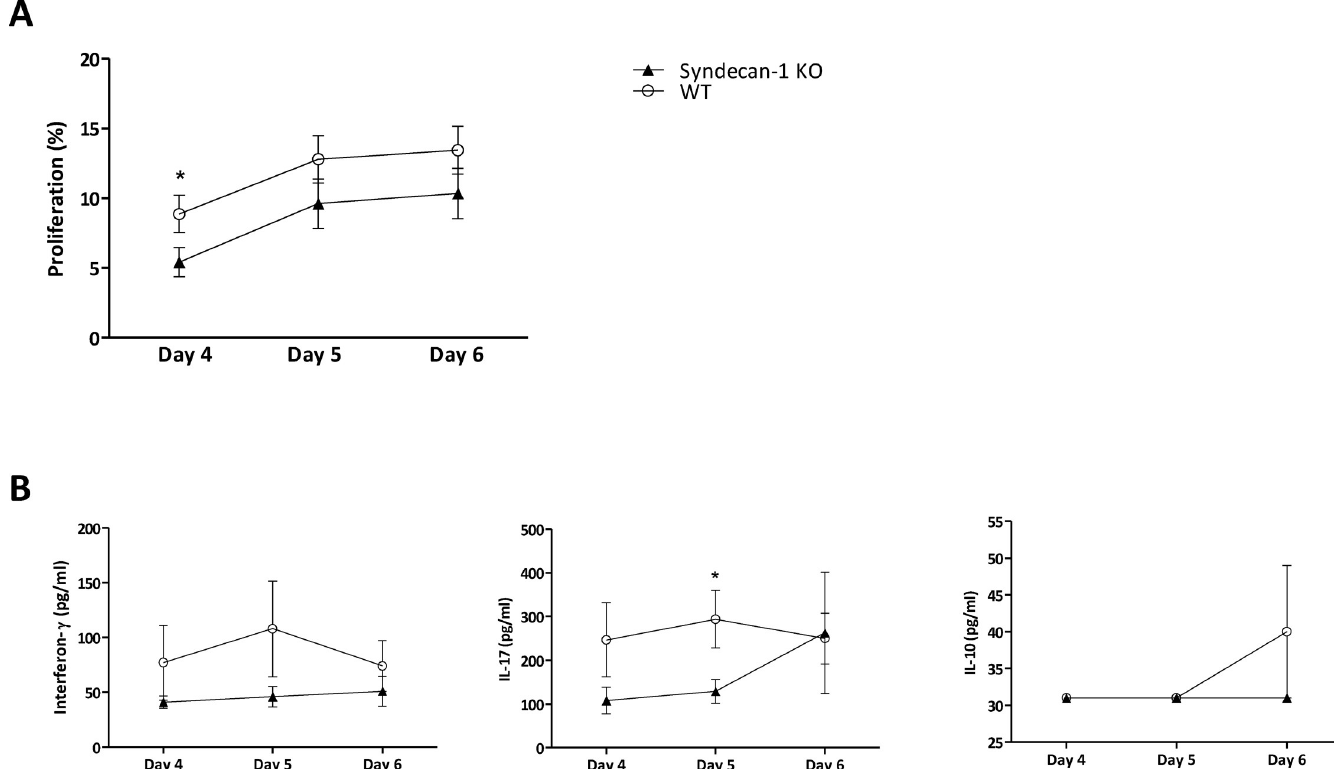
Fig 3. Proliferation and cytokine production are reduced in Sdc-1 deficient splenocytes upon stimulation with ConA. Proliferation of WT and Sdc-1 deficient splenocytes was determined in the presence of 0.1–0.25 μ g/ml ConA as analyzed by CFSE dilution using flow cytometry (A). Interferon- γ , IL-17 and IL-10 production by WT and Sdc-1 deficient splenocytes was determined in the presence of 0.25 μ g/ml ConA (B), as determined by ELISA. Proliferation and cytokine levels are expressed as means and standard error of means of 10 independent experiments. � p < 0.05, Mann Whitney test, unpaired t-test.